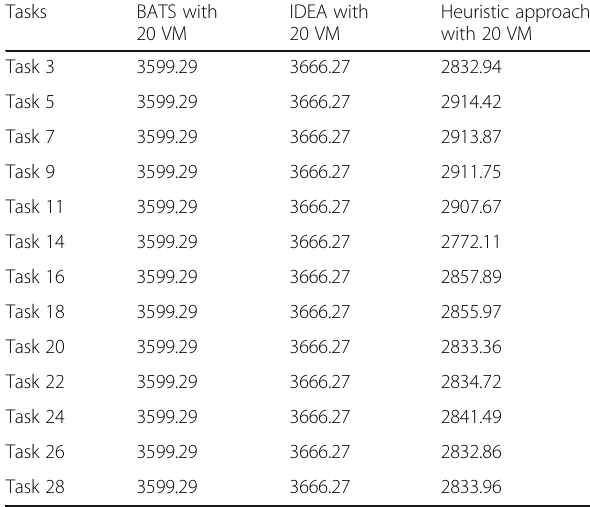
Table 15 Comparison of the proposed heuristic approach with the BATS and IDEA frameworks in terms of TAT in ms Tasks BATS with IDEA with Heuristic approach 20 VM 20 VM with 20 VM